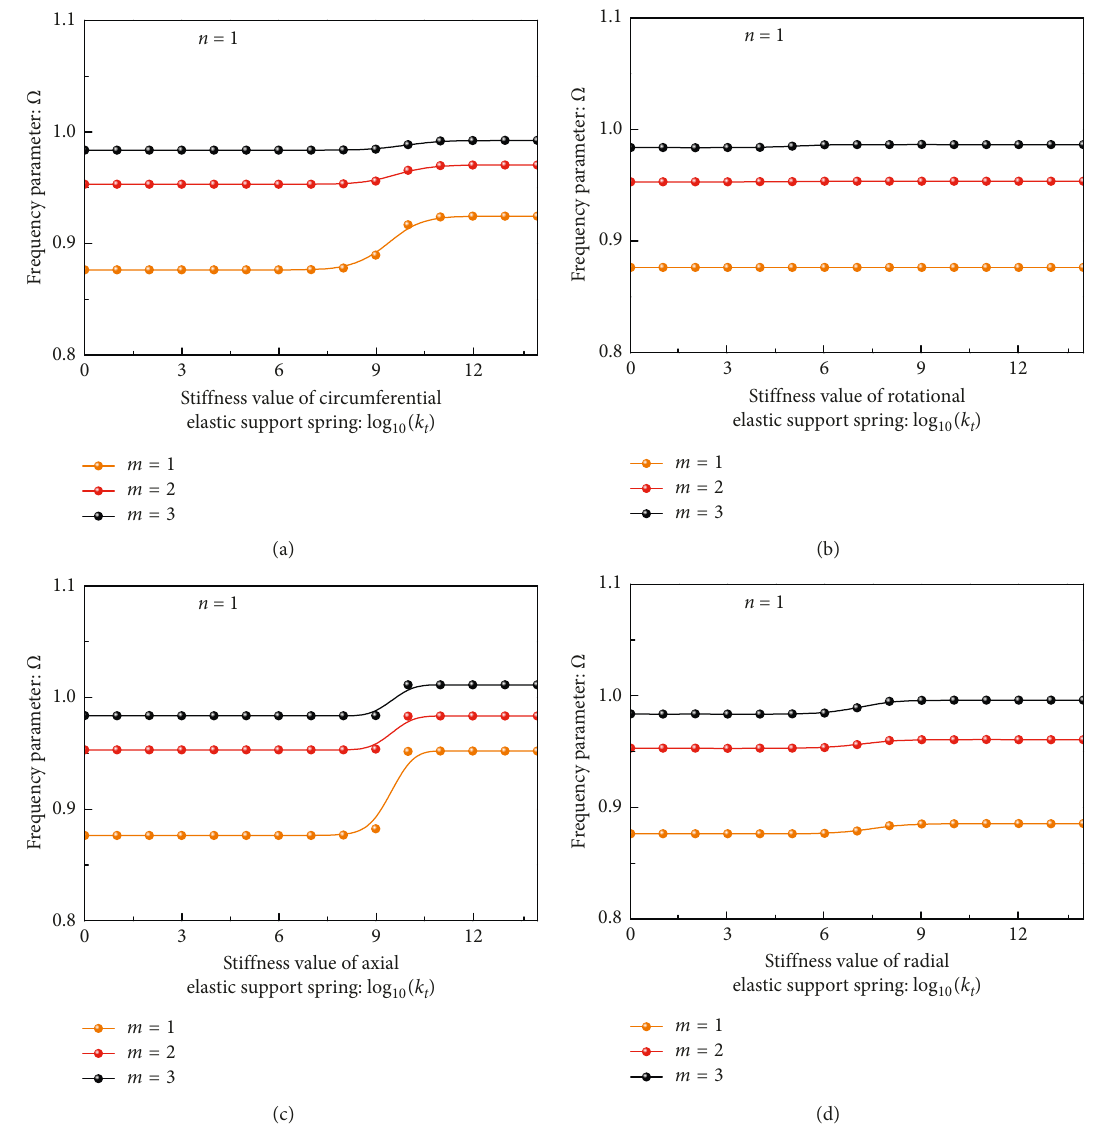
Figure 10: Frequency parameters Ω vs. stiffness of different elastic support